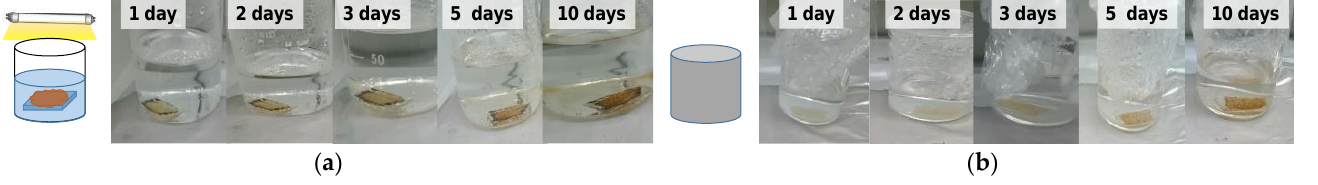
Figure 4. Effect of light irradiation on Ag + reduction. ( a ) Room light irradiation for 10 days; ( b ) Shielding light with aluminum foil for 10 days.